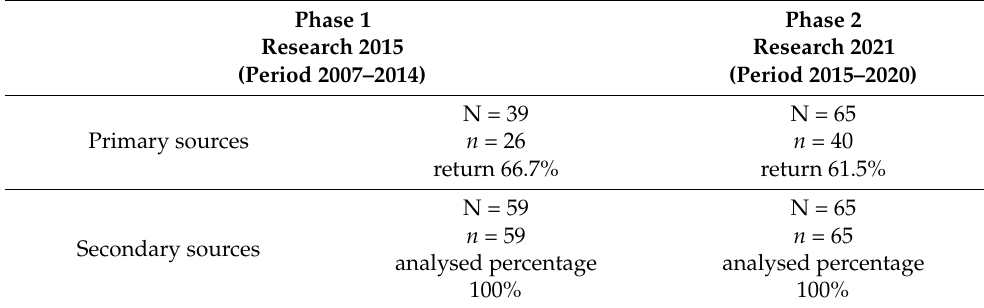
Table 1. Changes in the number of EMAS-registered organisations in Poland (population) and the research